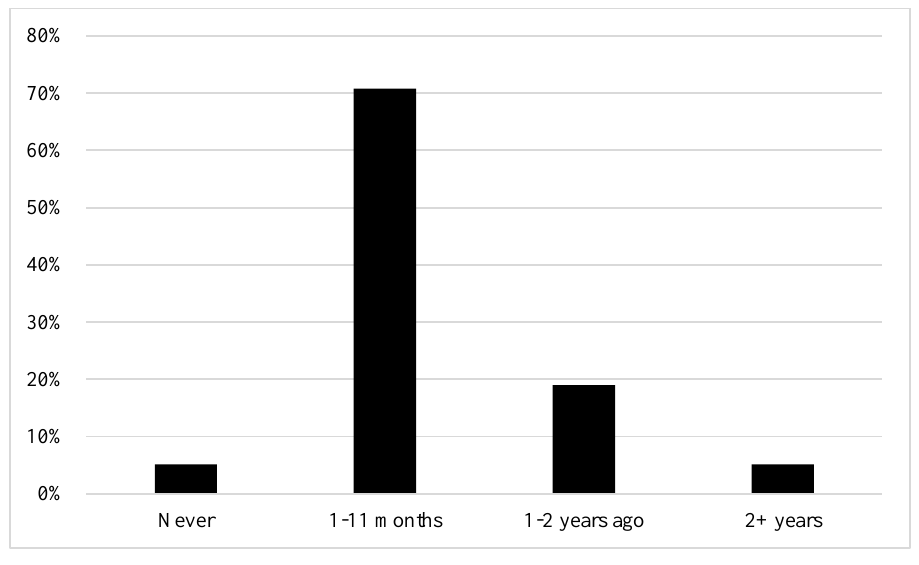
Figure 2 . Last time faculty checked textbook